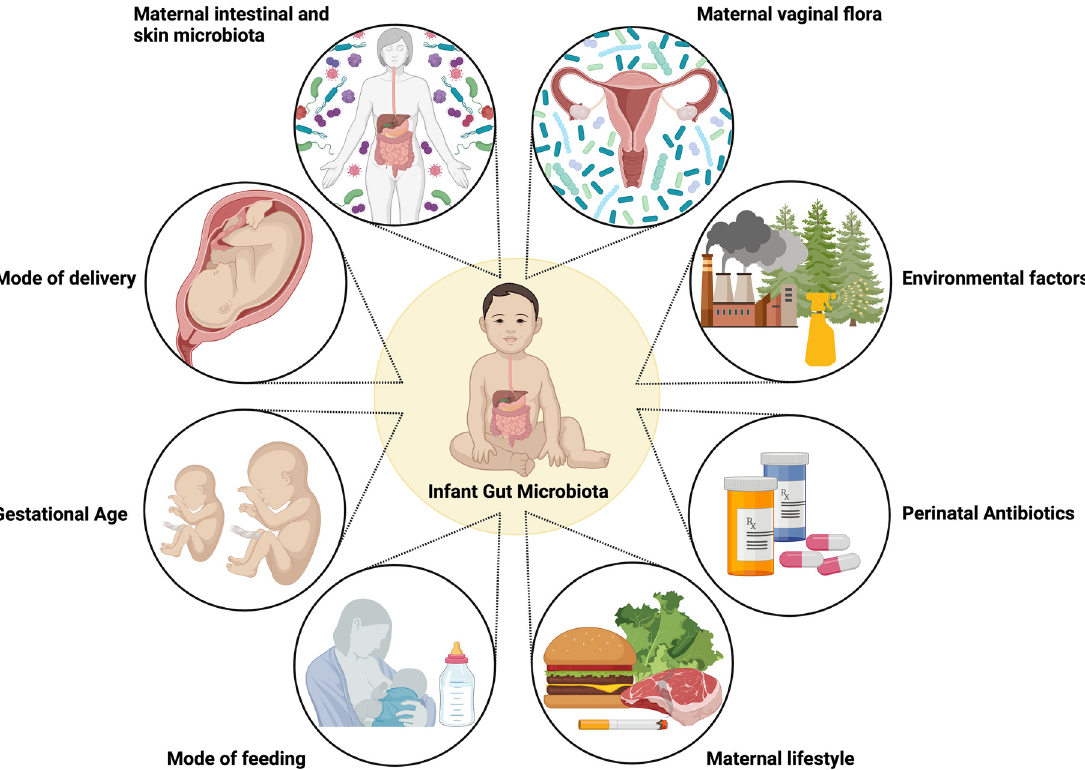
Figure 1: Factors influencing the development of the infant microbiome and immune system. A variety of factors exert important influences on the neonatal microbiome including mode of delivery, mode of feeding, perinatal exposure to